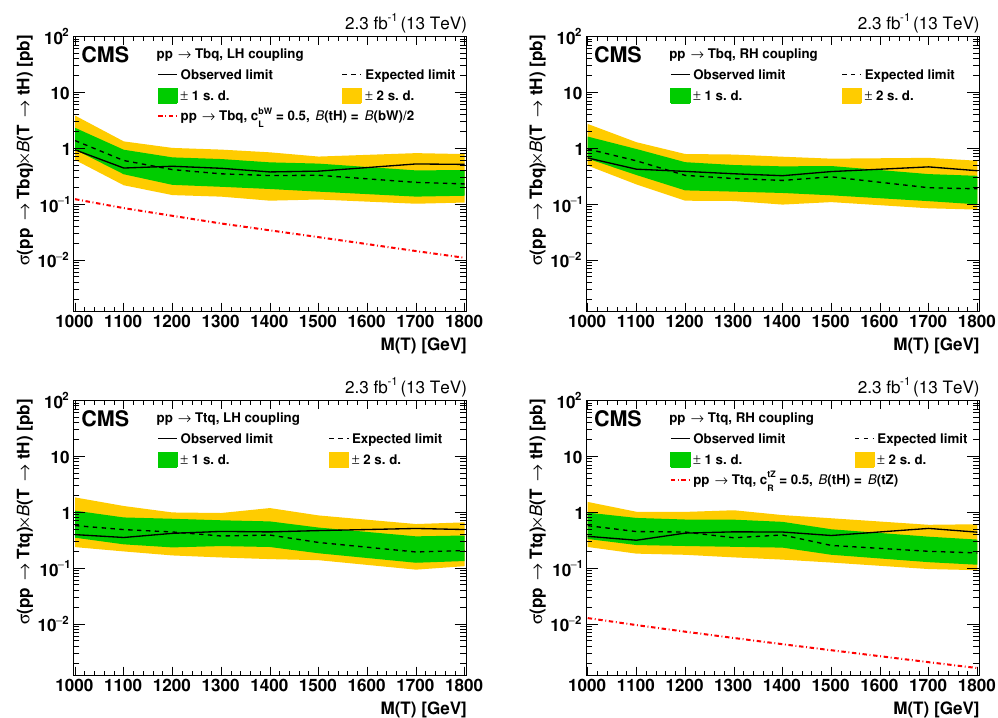
Figure 4 . The expected and observed 95% con(cid:12)dence level upper limits on the product of the signal cross section and the branching fraction B (T ! tH) for the processes pp ! Tbq (upper (cid:12)gures) and pp ! Ttq (lower (cid:12)gures), for di(cid:11)erent assumed values of the T quark mass, and with left-handed (left (cid:12)gures) and right-handed (right (cid:12)gures) couplings to the standard model third- generation quarks. The expected 1 and 2 standard deviation (s. d.) uncertainty bands are also shown. The limits are obtained assuming a resonance width of 10 GeV for the T quark. The dot- dashed curves in the upper left and lower right (cid:12)gures correspond to those predicted by the Simplest Simpli(cid:12)ed Model of refs. [18, 60], which predicts the existence of a left-handed and right-handed coupling for a singlet and doublet T quark, respectively. The benchmark coupling parameter values of c bW = 0 : 5 and c tZ = 0 : 5 are chosen for the L R